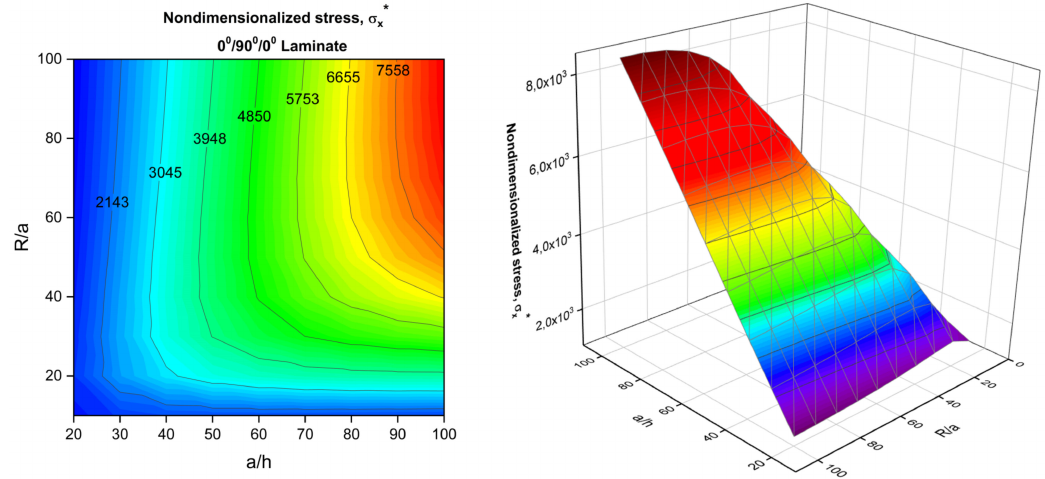
Figure 9. Nondimensional stresses, σ x ∗ , of (0 ◦ /90 ◦ ) spherical panels with the change of R/ a and a / h ratios.